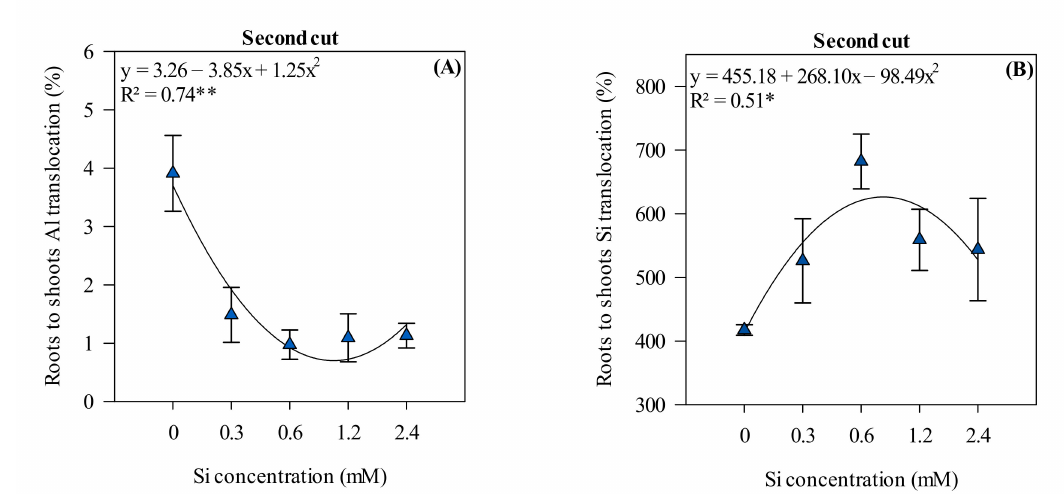
Figure 7. Roots to shoots Al translocation ( A ) and roots to shoots Si translocation ( B ) in the second cut as a function of increasing Si concentrations in Xara é s palisadegrass. Error bars indicate the standard deviation of the mean ( n = 4). * and ** = significant at 5 and 1% probability by F test